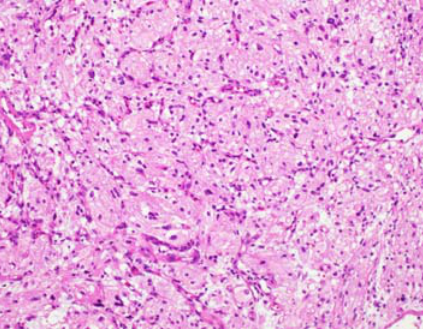
Figure2:H&Estainingonlow-poweredfield.Theinfiltrativetumor composed of polygonal cells, which arranged in small nests and intervened with blood vessels. These tumor cells posed abundant finely granular eosinophilic to foamy cytoplasm and moderately irregular nuclei.